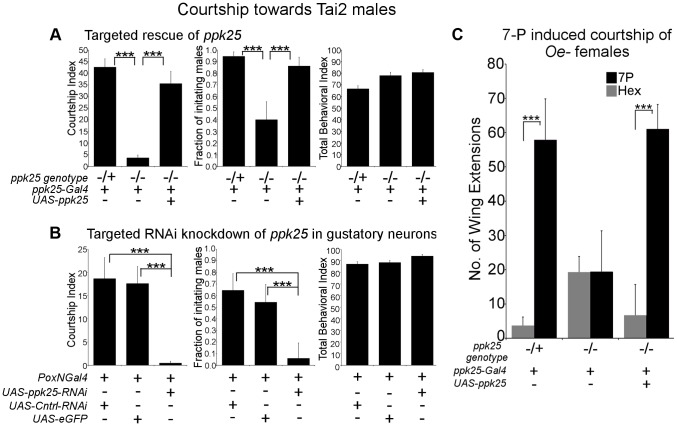

ppk25 function in gustatory neurons is required for courtship stimulation by Tai2 males or 7-pentacosene.A. ppk25 function in cells defined by ppk25-Gal4 expression is required for male courtship directed at Tai2 males. CI, fraction of males initiating courtship toward decapitated Tai2 males and TBI were calculated for ppk25 null mutant males, control males with one wild-type copy of ppk25, and ppk25 mutant males where ppk25 expression had been restored in ppk25 cells. N = 36–40; Mean ± SEM; ***p<0.001. B. Targeted RNAi knockdown of ppk25 in all gustatory neurons reduces courtship toward Tai2 males. CI, fraction of males initiating courtship toward decapitated Tai2 males and TBI were calculated for males expressing ppk25 RNAi in gustatory neurons using Poxn-Gal4. Control males expressed eGFP or a control RNAi targeting CG13895 under control of Poxn-Gal4. Error bars are SEM; N = 31–34; ***p<0.001. C. The number of wing extensions performed by males with normal or mutant copies of ppk25, or by ppk25 mutant males in which ppk25 function is restored in ppk25 cells, was measured in the presence of oe- females painted either with solvent alone or with 7-Pentacosene. oe- females were pierced through the head with forceps, contributing to the low courtship background and assays were conducted in the light. n = 20–24; Mean ± SEM; ***p<0.001.